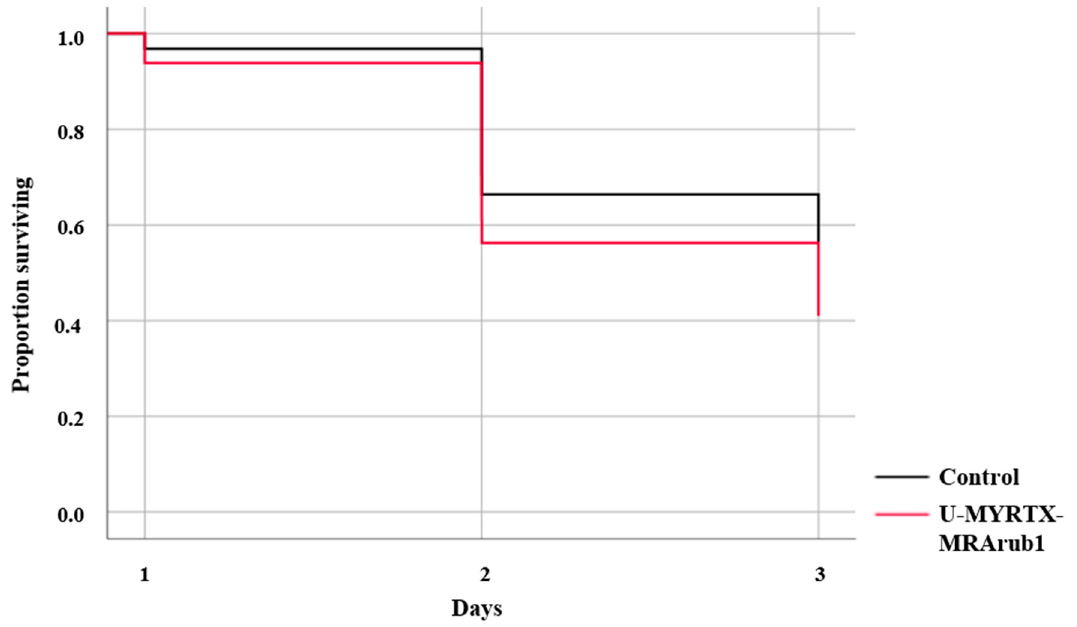
Figure 3. Insecticidal activity of M. rubra peptide U-MYRTX-MRArub1. A. pisum survival was monitored during 3 days of feeding on an AP3 diet mixed with the test peptide (500 µg/mL). Survival data were evaluated by Kaplan-Meier analysis and comparisons between the two groups were based on log-rank tests. Statistical data are shown in Table S1. The peptide treatment induced a small but significantly higher mortality in aphids compared to the diet control treatment (diet diluted with distilled water).